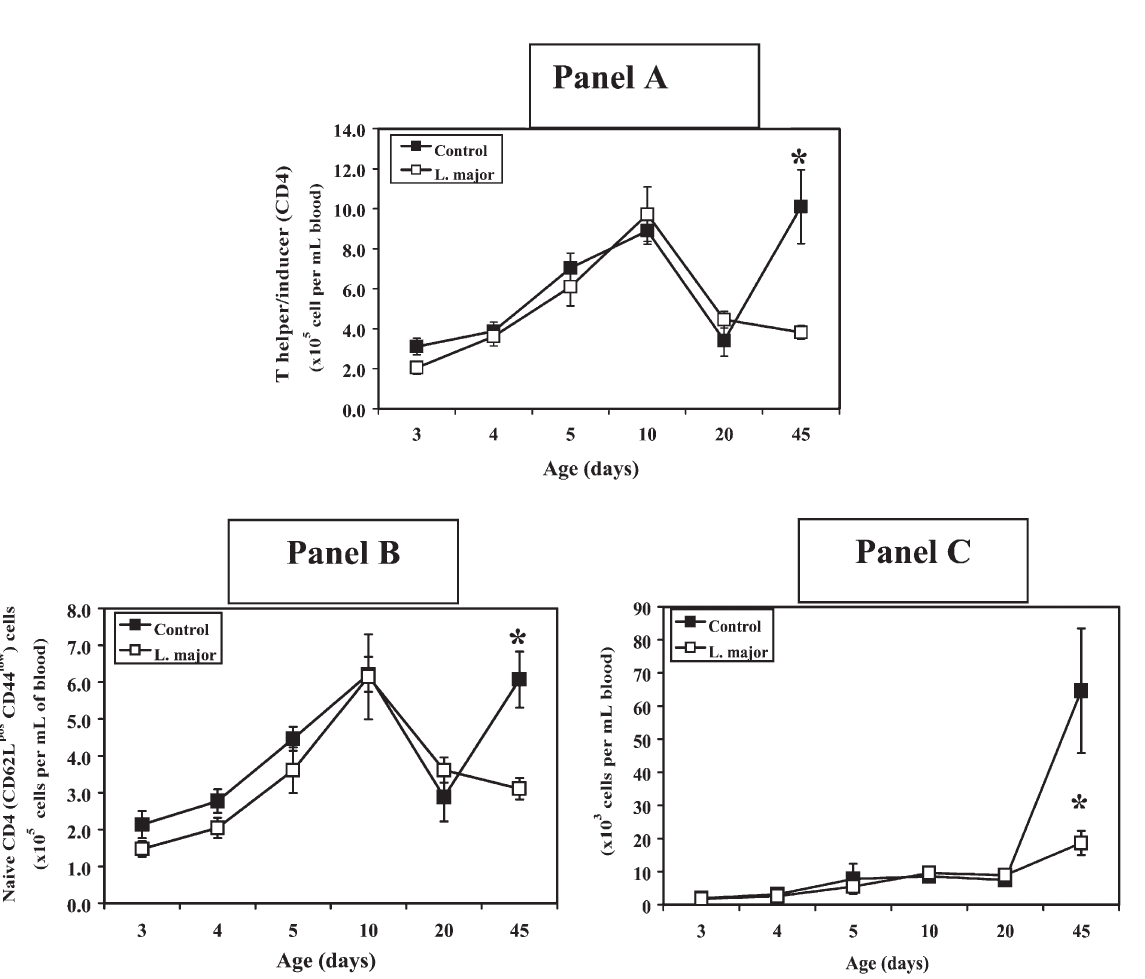
FIGURE 3 Absolute numbers of Th (CD4, Panel A), naı¨ve Th (CD62 pos CD44 low , Panel B) and memory Th (CD62L neg CD44 high , Panel C) cells in blood of pups of various ages delivered from dams treated during gestation with L. major (175 m g/mouse i.p.) or saline. Data points are mean ^ SE of 5 samples/age, except 6 for d20 in saline group; and 5 sample/age in L. major group. Samples represent pools of randomized pups (d3-10, 5–14/pool; d20, 2/pool; d45, 1 pup). Statistical significance ( p , 0 : 05; df ¼ 1; F ¼ 4 : 9 for Th; 2.4 for naı¨ve and 5.3 for memory) for treatment effects among groups was derived from two-way ANOVA. Interaction between treatment and age suggest that effects are seen only on d45 ( F statistic: na € ıve ¼ 2 : 4 and memory ¼ 5 : 3 ; df ¼ 5 ; p , 0 : 05 Þ : Post hoc analyses with Student’s t -test (two-tail) revealed differences among groups per age (*, p , 0 : 05; df ¼ 8; t statistic of 2 3.35 (CD4), 2 3.64 (naı¨ve), and 2 3.64 (memory). See “Statistical analysis” section for further details. At some ages, symbols obscure SE